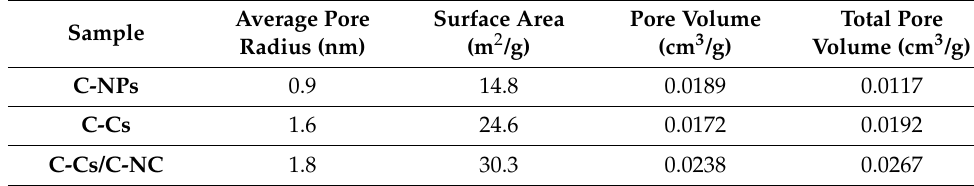
Table 1. The surface characteristics of the prepared C-Cs and